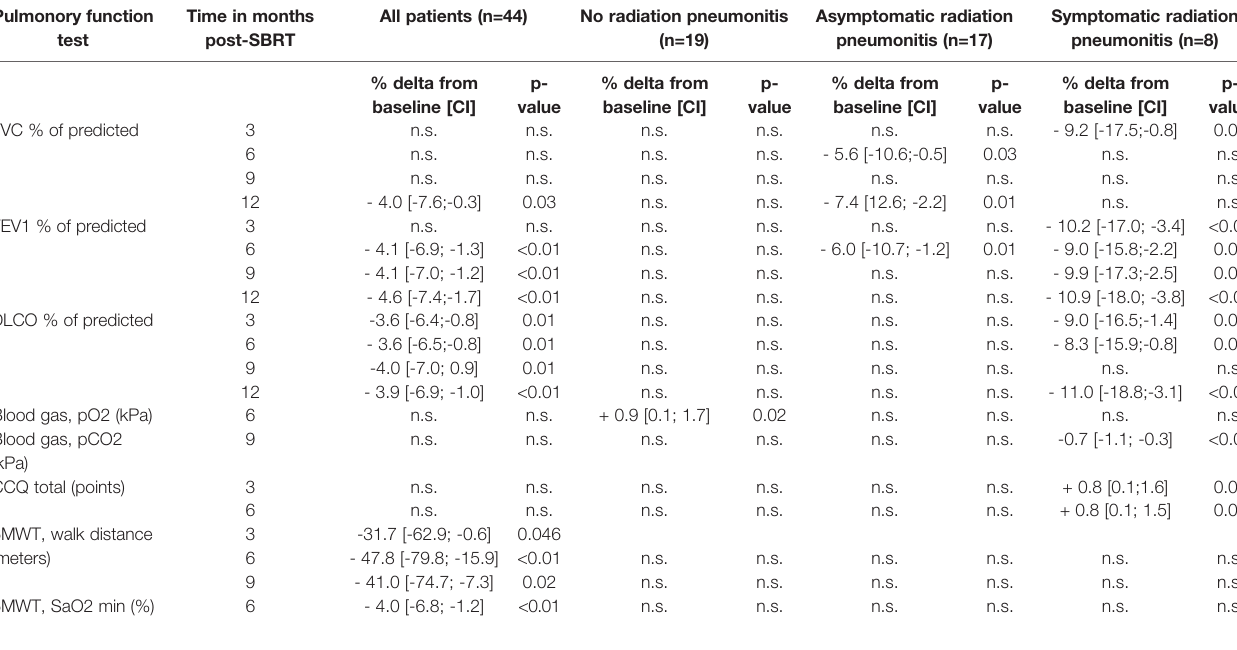
TABLE 2 | Signi fi cant delta percent changes in mean values from baseline according to a linear mixed model. Pulmonory function